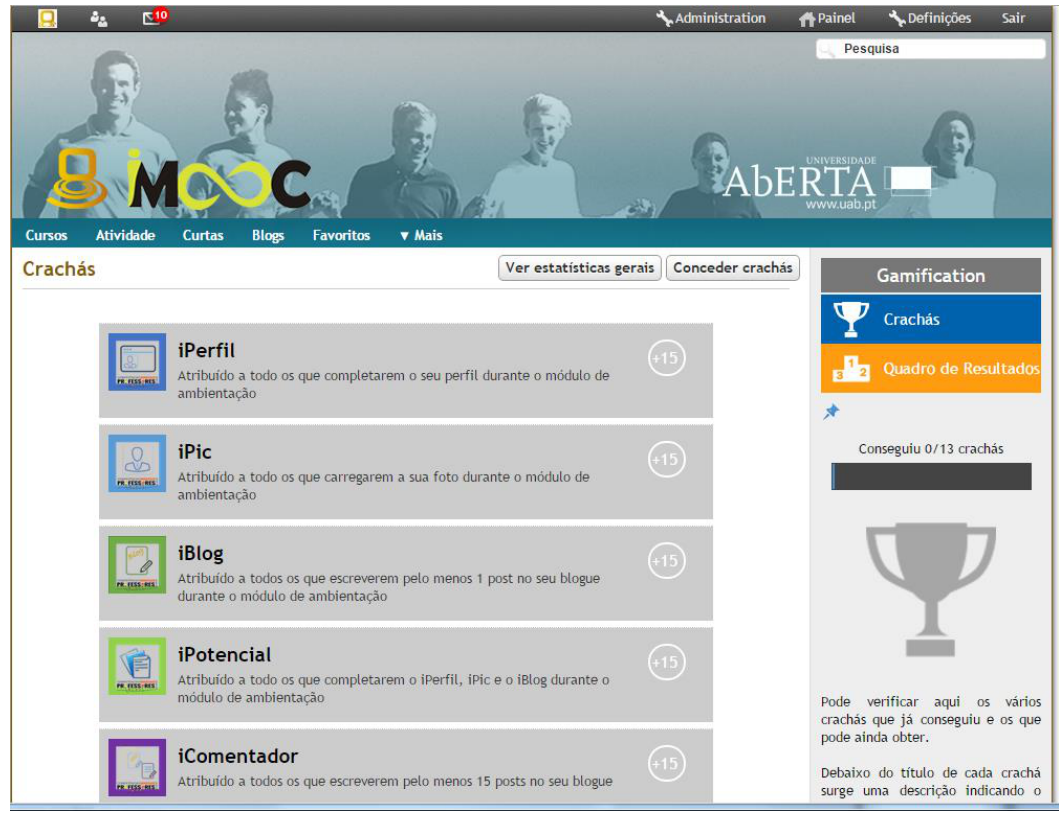
Figure 1. Social-networking educational gamified platform showing a subset of the achievements.